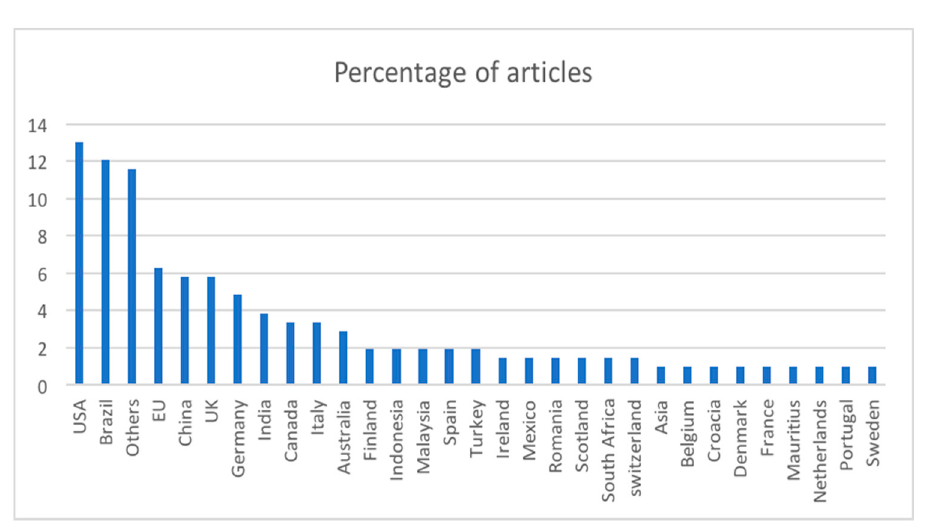
Figure 5. Most productive countries producing renewable energy and sustainability articles.